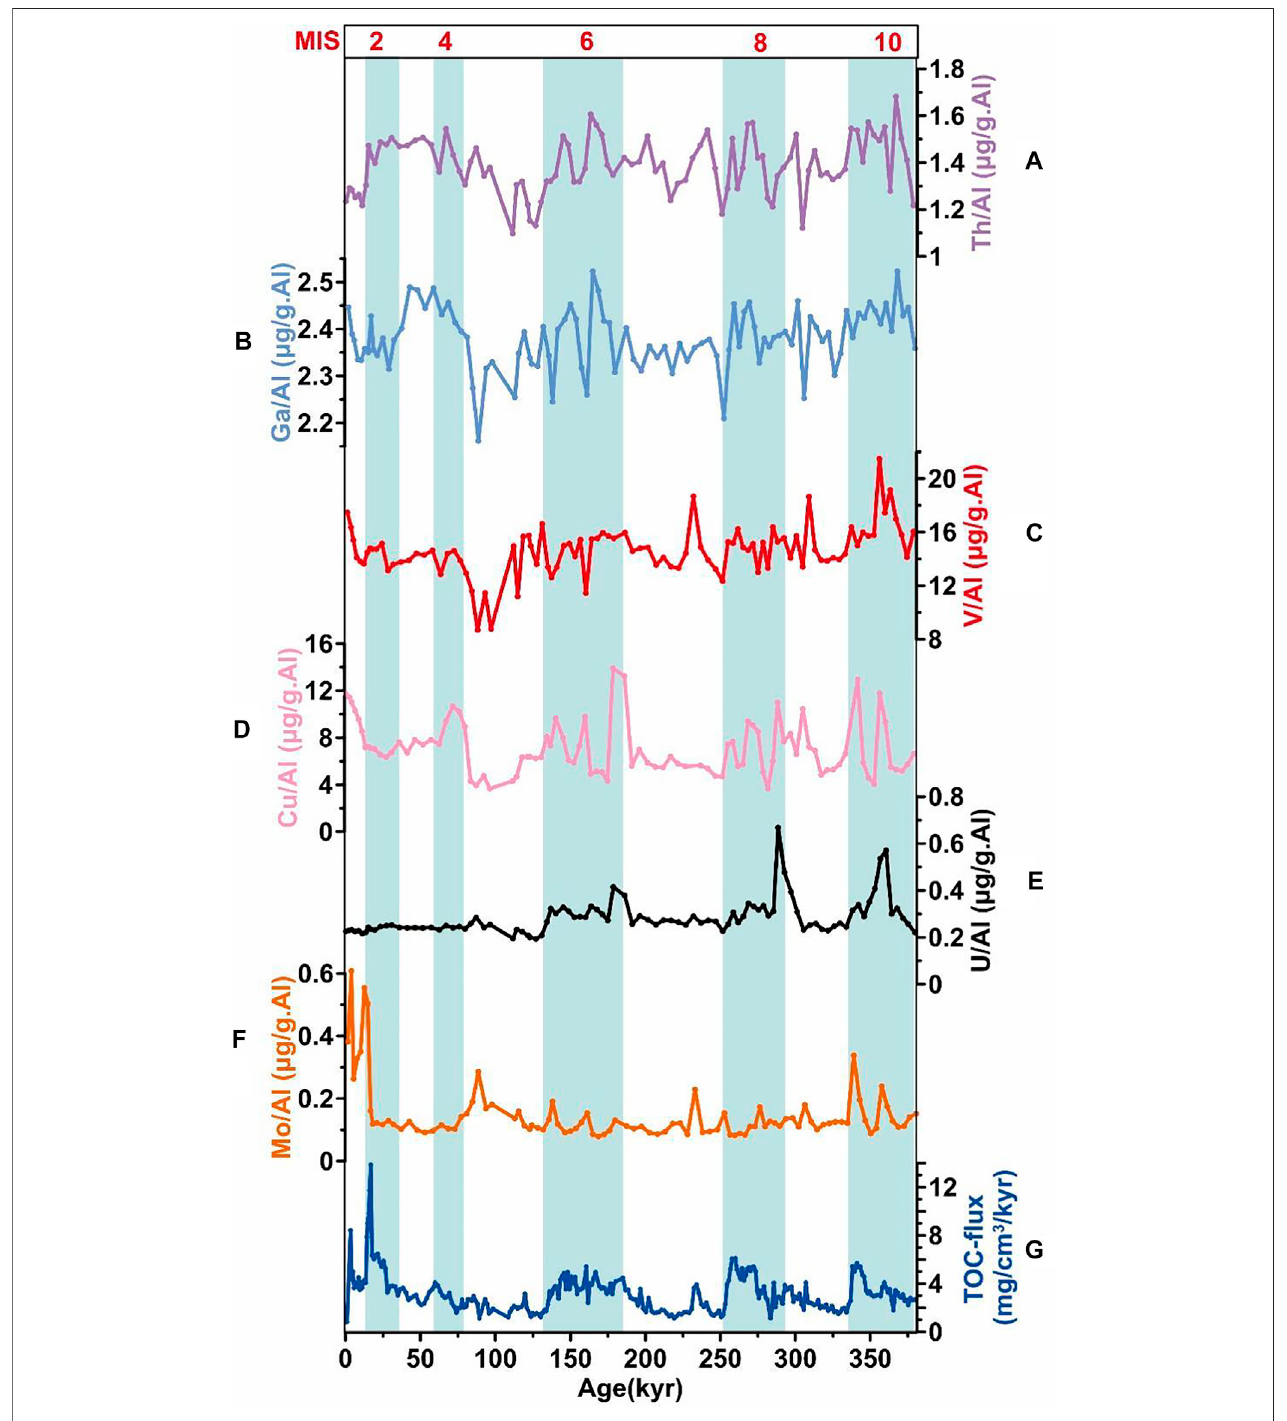
FIGURE 4 | Comparison of RSEs enrichment with TOC in core St10-PC. (A) Thorium (Th/Al), (B) gallium (Ga/Al), (C) vanadium (V/Al), (D) copper (Cu/Al), (E) uranium (U/Al), (F) molybdenum (Mo/Al), (G) TOC contents; blue shadow: glacial periods.